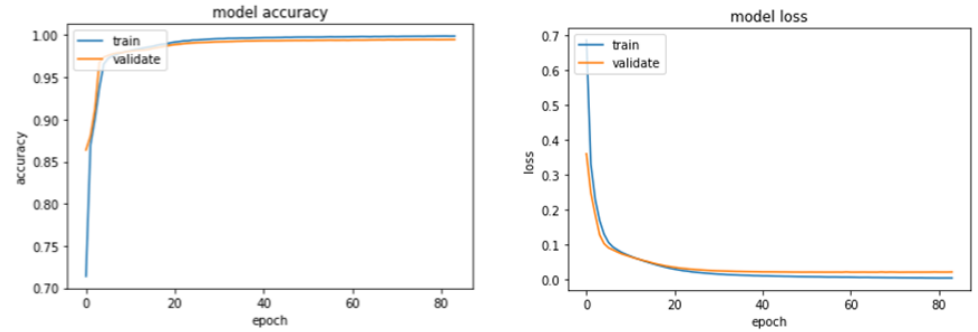
Figure 10. Training and validation loss curves on RNN